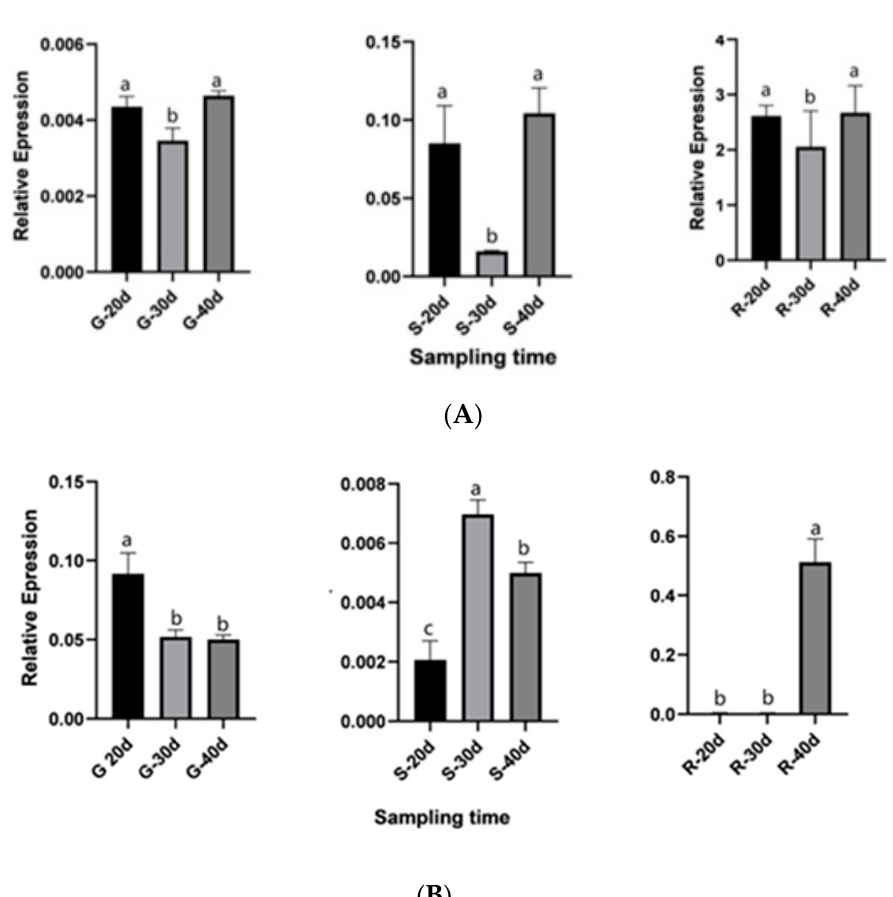
Figure 10. Relative expression levels of UFGT1 and UFGT2 genes in the same cultivars at different periods. ( A ) Relative expression of UFGT1 in different cultivars. ( B ) Relative expression of UFGT2 in different cultivars. Bars marked with the same and different letters indicate non-significant and significant differences, respectively. The significance level is α = 0.05. R, FZ-72 (red calyx); G, Baitao K (green calyx); S, MG5 (stripped calyx).